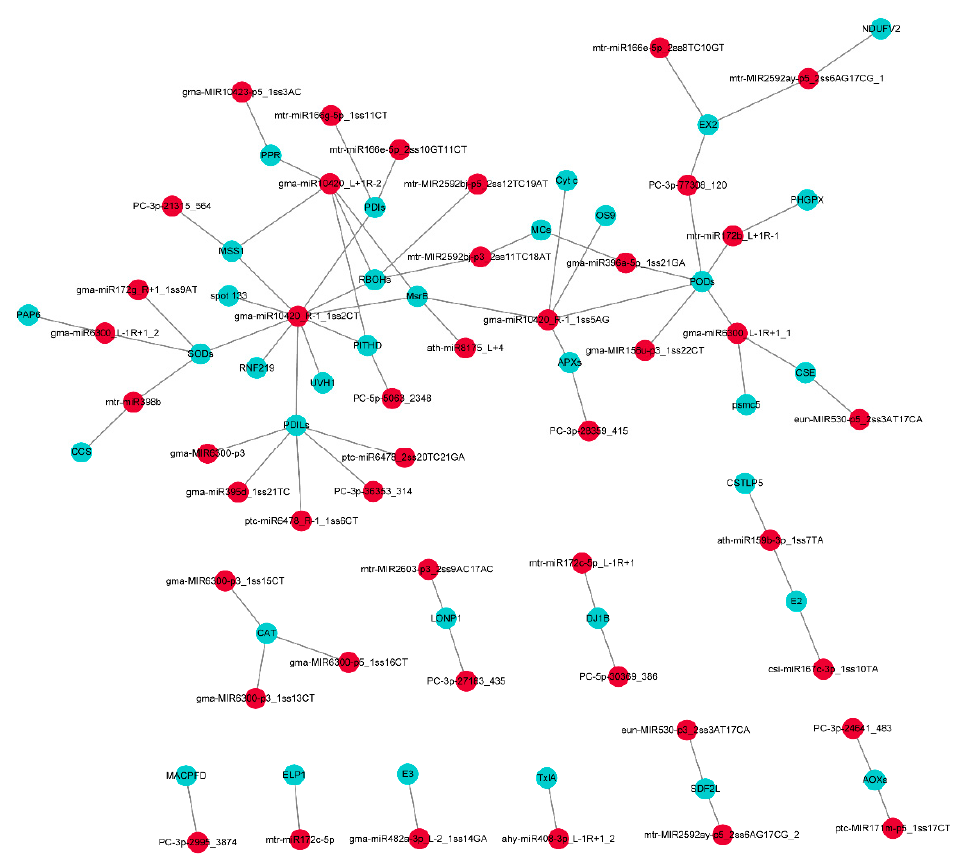
Figure 6. The miRNA-mediated regulatory networks responses to Al stress in peanut. Red circles represent the differentially expressed miRNAs, and blue circles represent the target genes of differ- entially expressed miRNAs. Abbreviations for target genes are listed in Table S7.